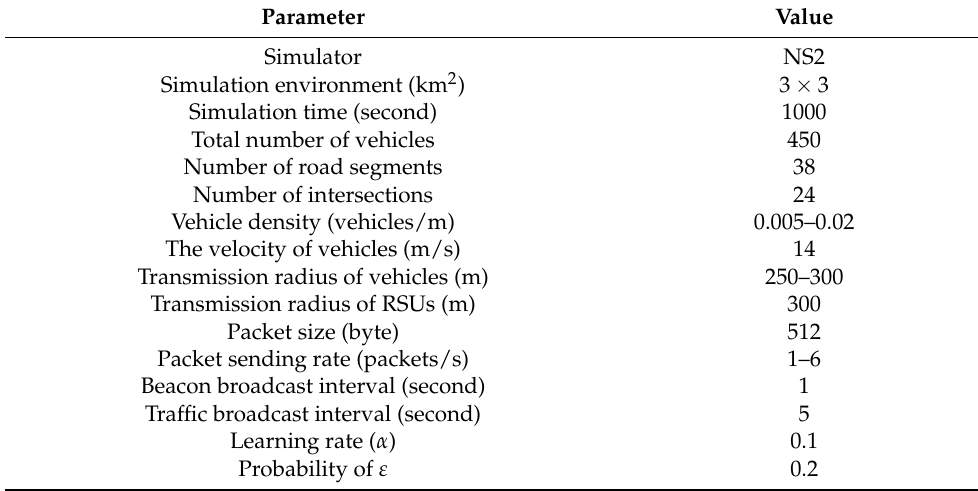
Table 5. Simulation